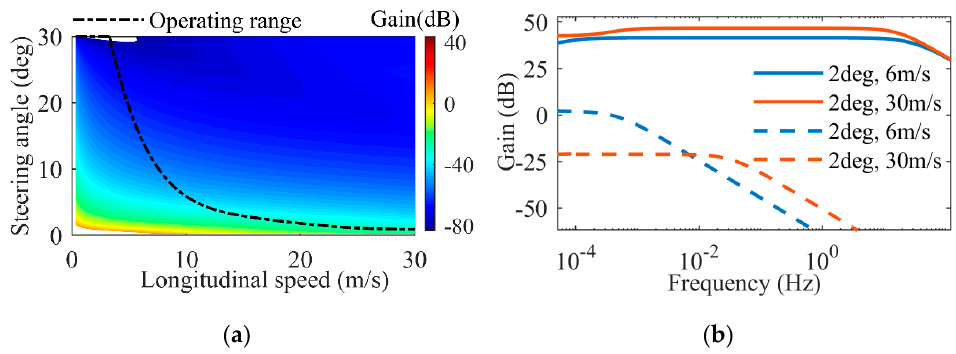
Figure 8. Comparative results of coupling effect on lateral dynamics: ( a ) amplitude-frequency characteristics from F T to ω and δ f to ω ; ( b ) open-loop gains from F T to ω .